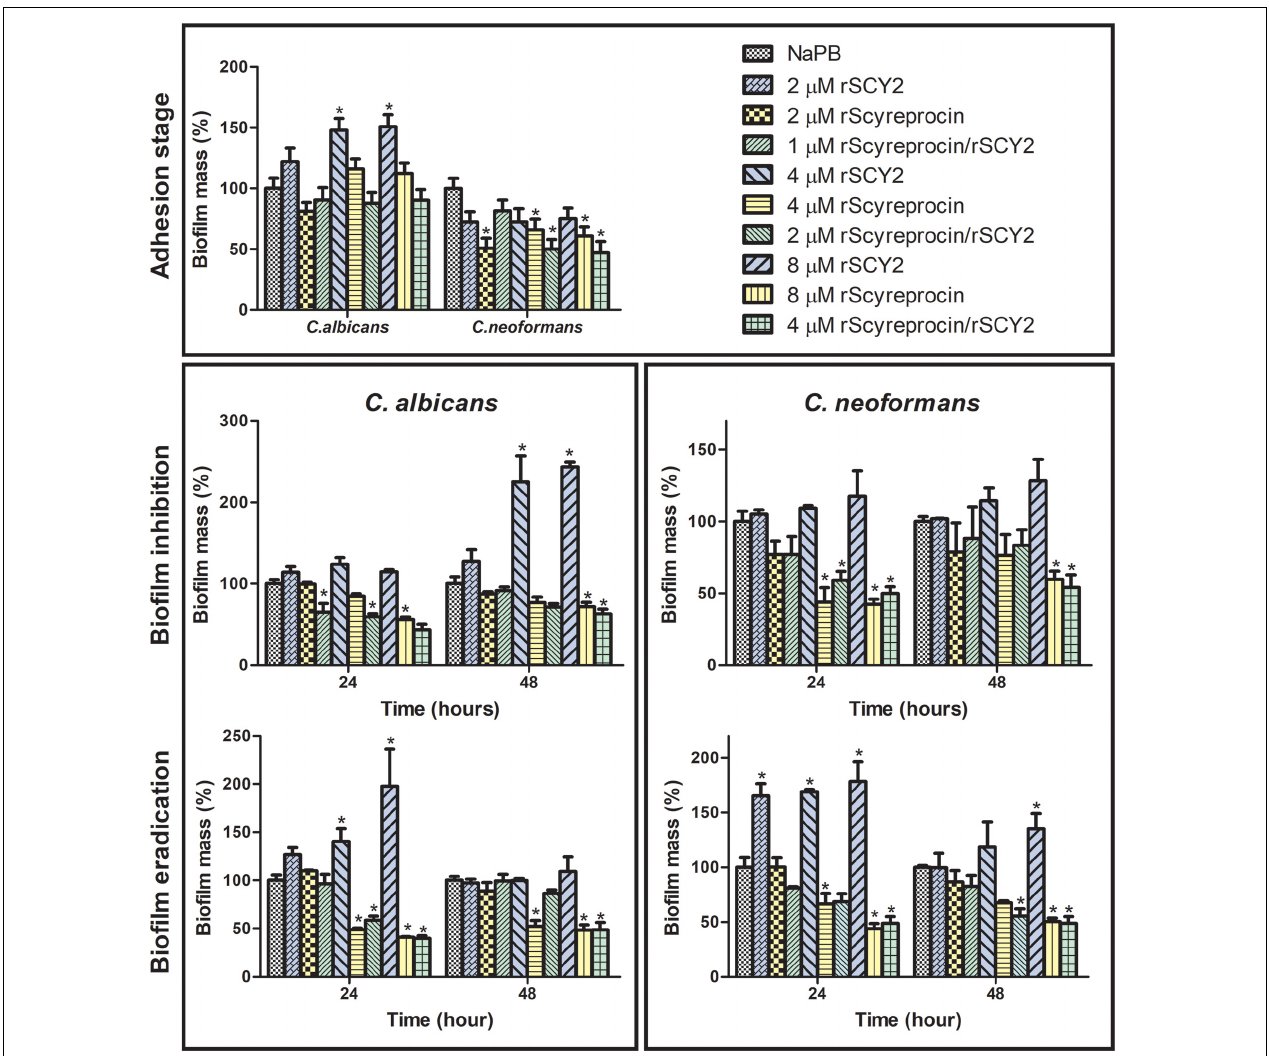
FIGURE 7 | Effect of rScyreprocin and rSCY2 on fungal biofilms formed by Cryptococcus neoformans and Candida albicans . Yeasts or the corresponding biofilms from C. neoformans and C. albicans were kept untreated or were treated with various concentrations of rScyreprocin, rSCY2, and rScyreprocin/rSCY2 and then processed to crystal violet staining for evaluation of biofilm formation levels. Data represent means ± SEMs from three independent experiments ( n = 3), representing the relative percentage of biofilm mass (control groups were normalized to 100%). ∗ P < 0.05 versus control (two-way ANOVA, Bonferroni